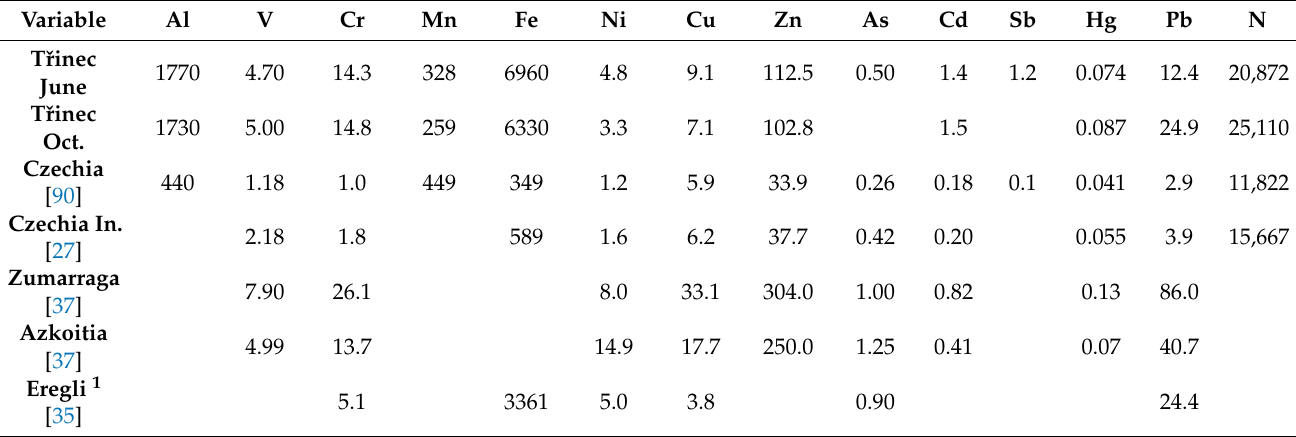
Table 2. Median values of element contents in moss specimens (ug · g − 1 ) and (wt.%) for Al, Fe and N compared to levels reported in relevant studies in Czechia [27,90], Spain (Zumarraga, Azkoitia) and Turkey (Eregli) [35]. Variable